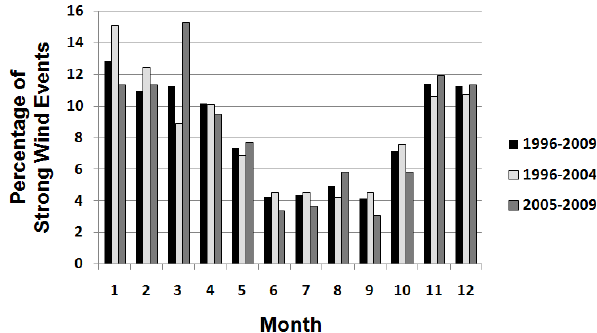
567 Fig. 2. Monthly distribution of the Strong Wind Events for the pe- Fig. 2: Monthly distribution of the Strong Wind Events for the periods studied (in bars) 568 riods studied (in bars) and a polynomial adjust for the total period and a polynomial adjust for the total period 1996-2009. 569 570